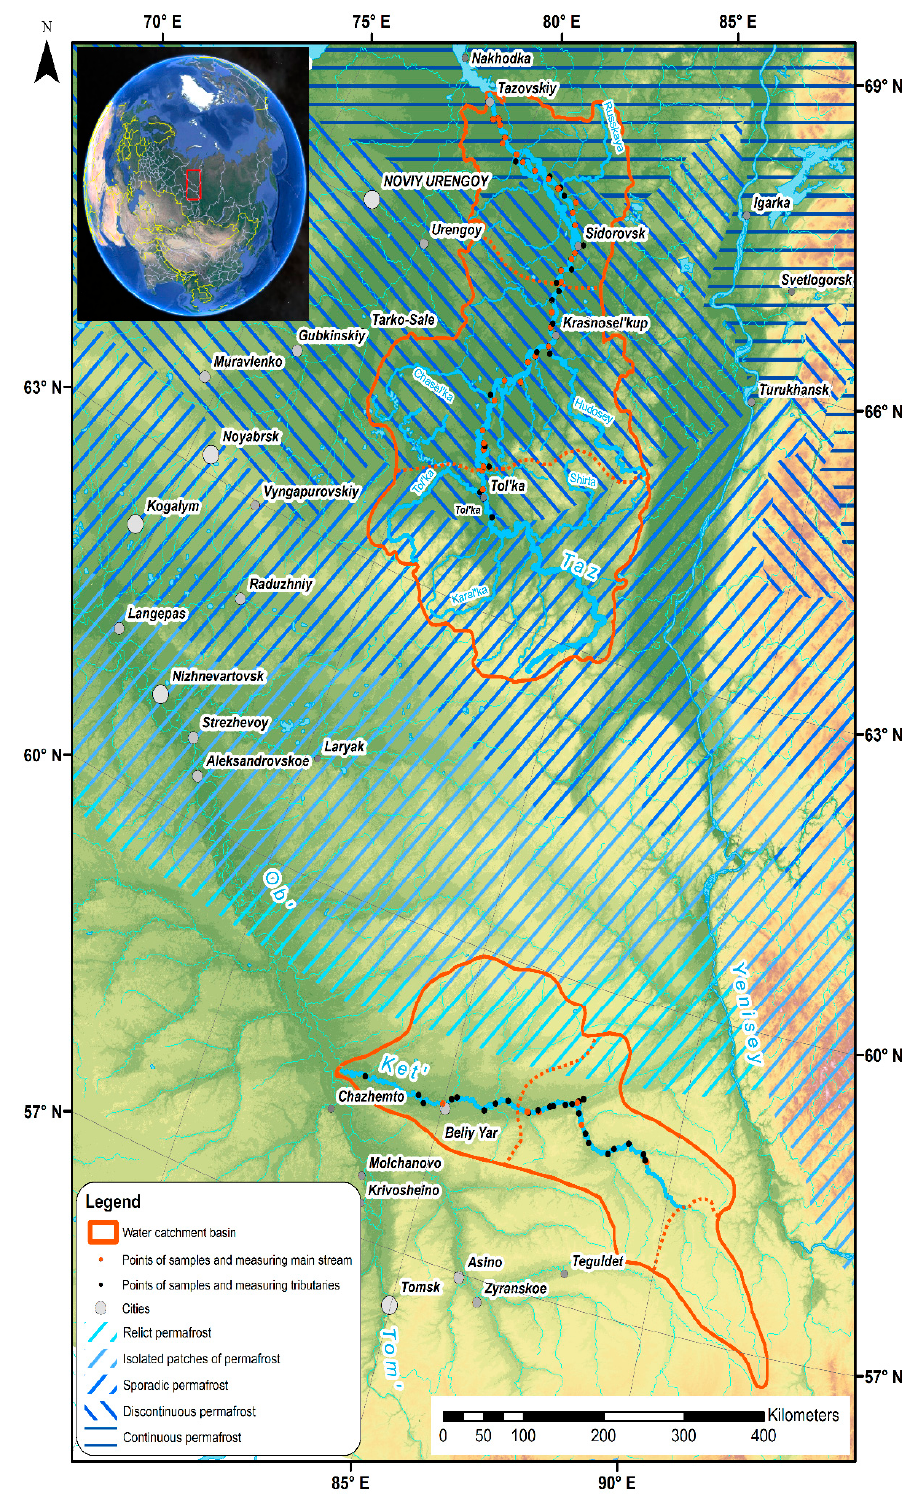
Figure 2. Map of the two studied river basins (Taz in the north and Ket in the south). The sampling points of the main stem and tributaries are shown by red and black circles, respectively.